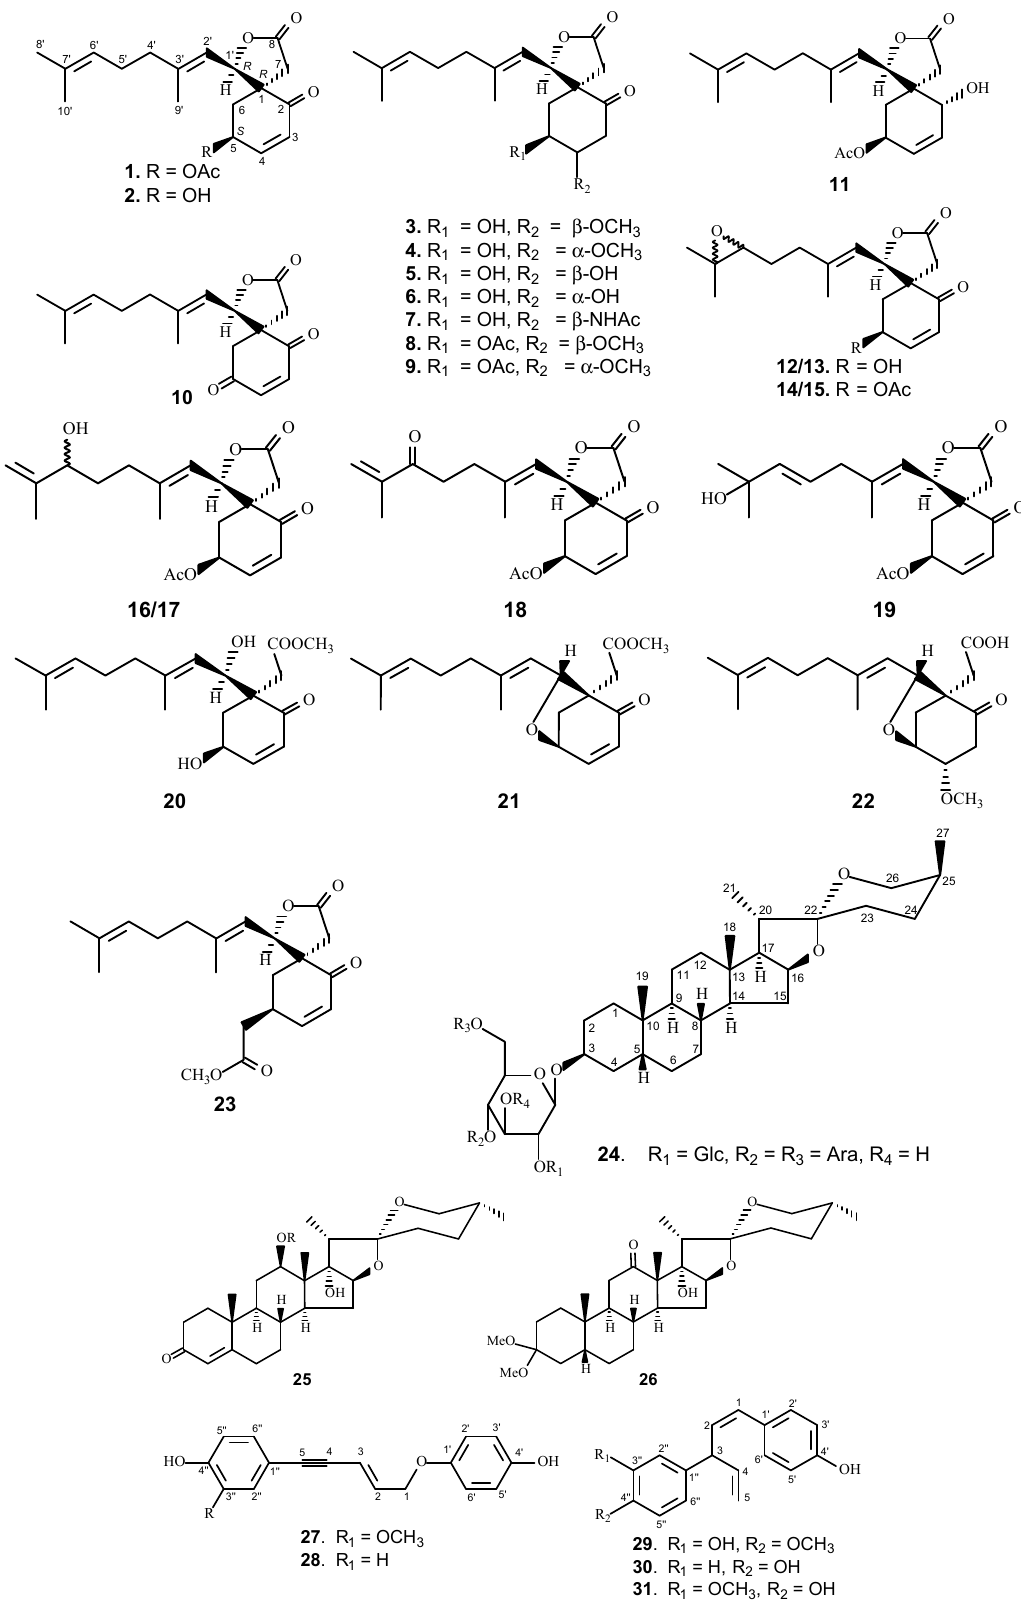
Figure 1. Cont. Figure 1.